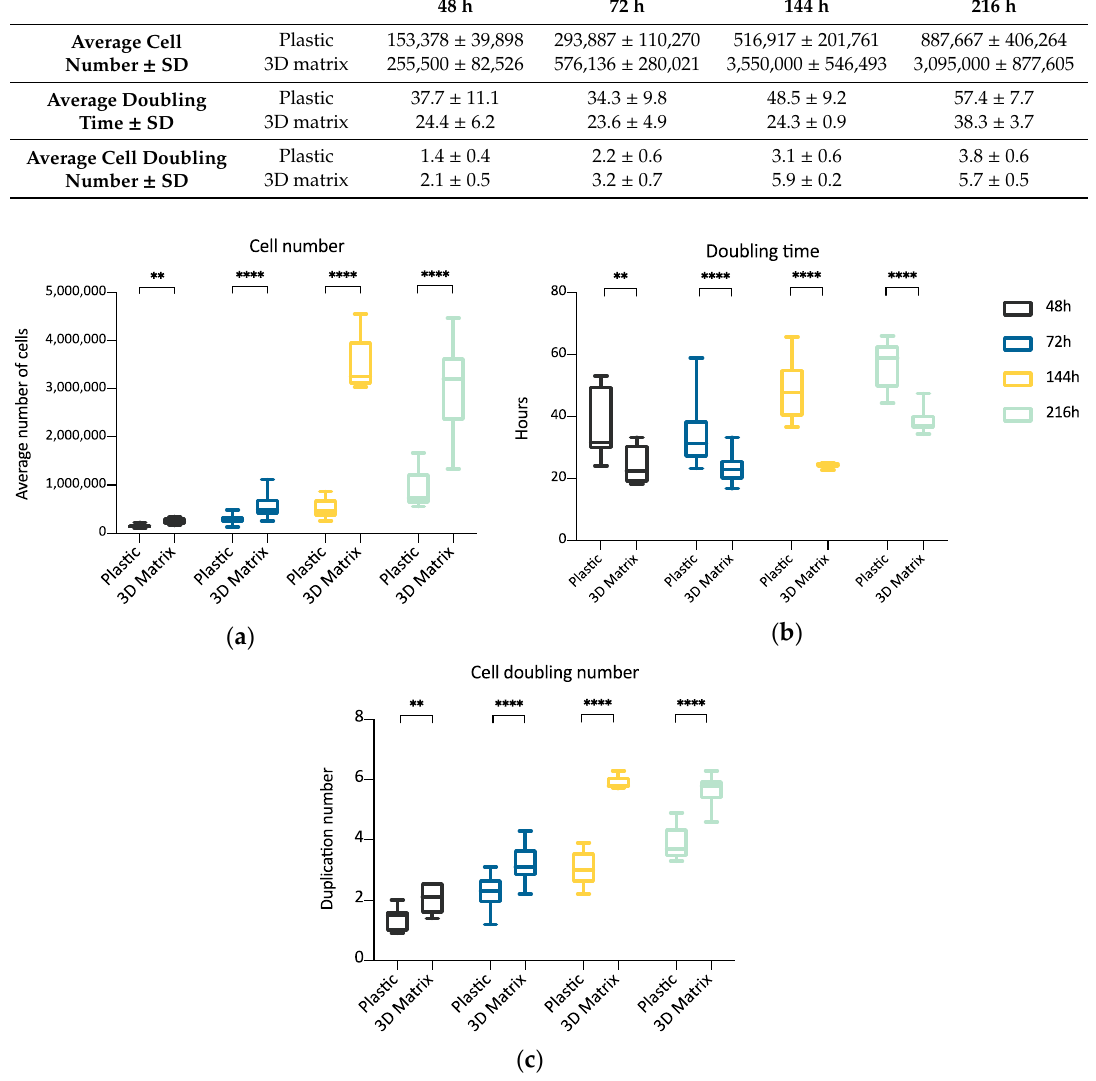
Figure 2. Box plot illustrating differences in average cell number ( a ), cell doubling time ( b ), and cell doubling number ( c ) obtained from cells maintained on plastic surface or inside a 3D matrix prepared from PPP, at different time points (48, 72, 144, 216 h) (n = 5). Statistically significant differences are indicated as follows: ** p ≤ 0.01, **** p ≤ 0.0001. Table 1. Average cell number, doubling time and cell doubling number ±SD obtained at different time points (48, 72, 144, 216 h) from ADMSCs cultured on 2D plastic surface or 3D fibrin-based gel prepared from PPP (n = 5). Cells were seeded at a density of 6000 cells/cm 2 in 3.5 cm Petri dishes.